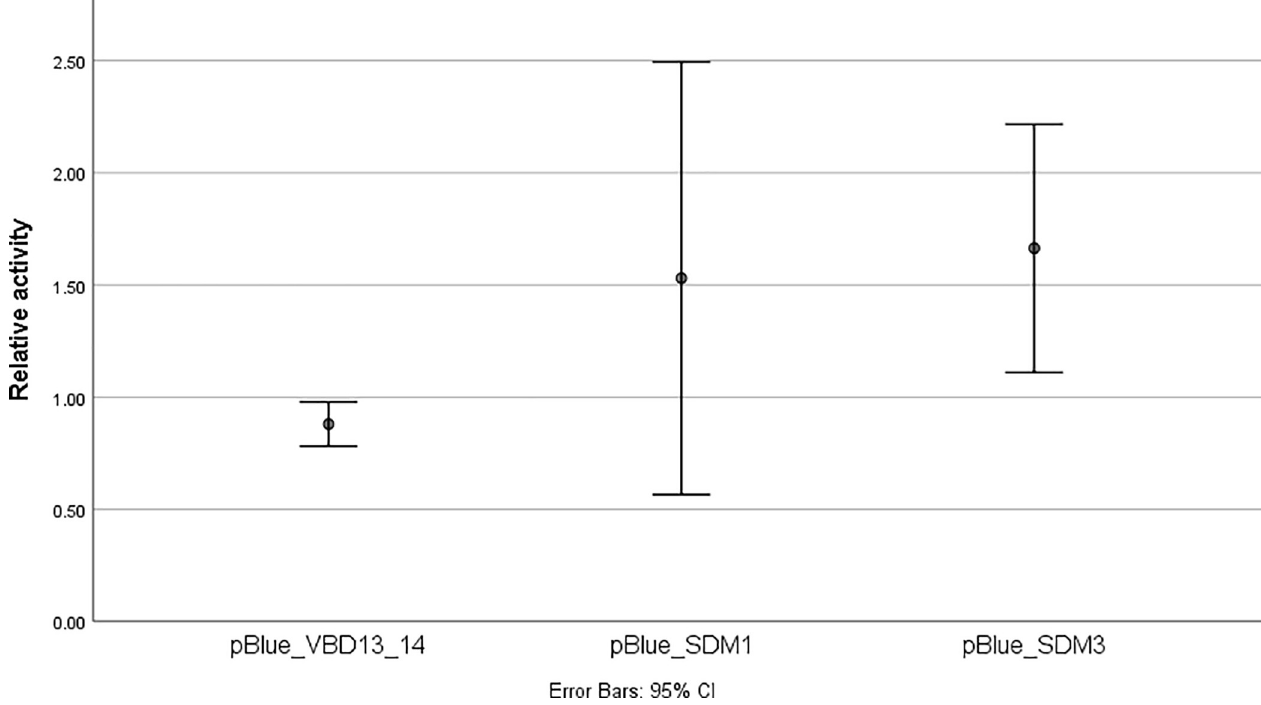
Fig 4. Transcriptional activity of HPV31 full-length LCR variants. Ratio of β -galactosidase activities of BHK cells transfected with reporter constructs containing different HPV31 LCR variants to that of the untransfected BHK cells.